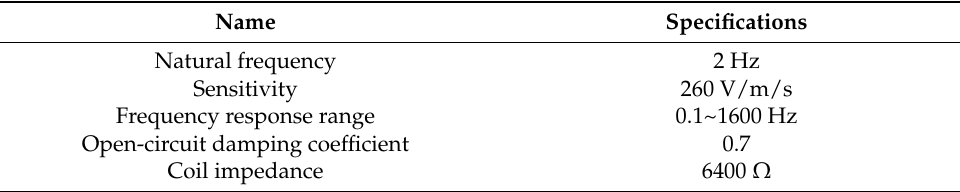
Figure 5. GN309 remote real-time intelligent microtremor detector. Table 1. GN309 detector parameters.